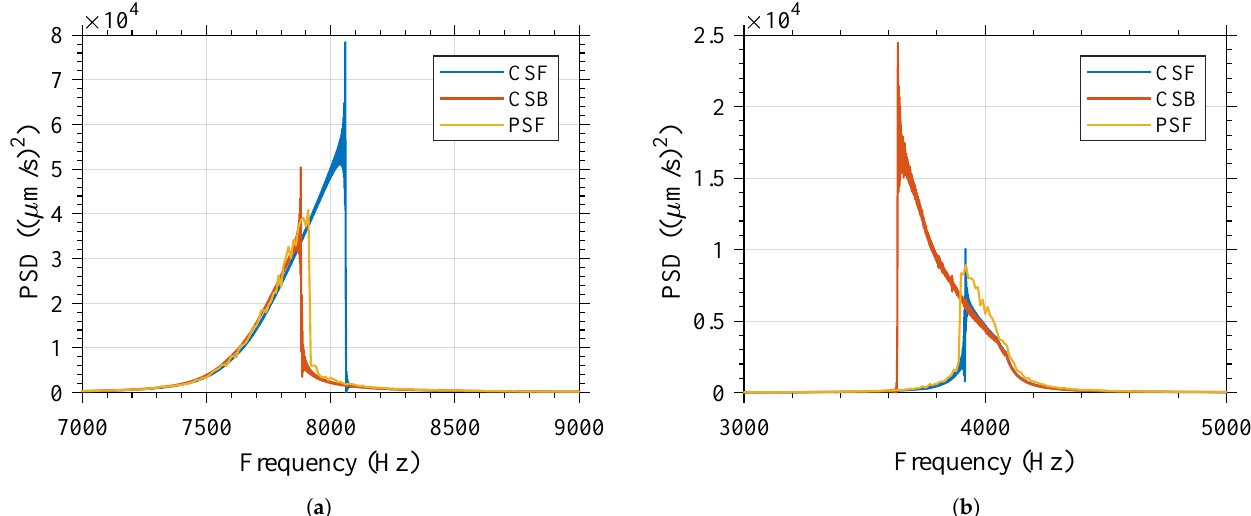
Figure 8. Influence of the excitation signal type ( CSF , CSB , or PSF ) on the frequency behavior when the amplitude of the excitation signal is 20V ( a ) Variant 1 and ( b ) Variant